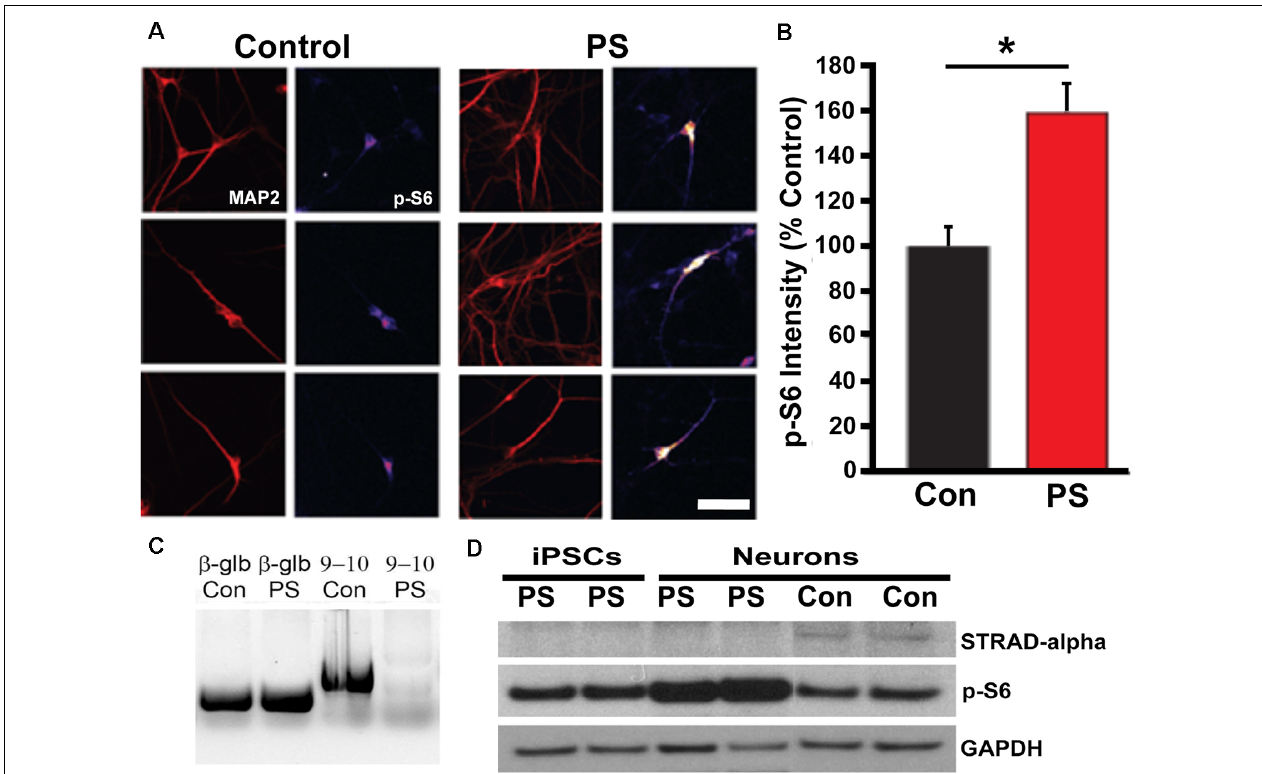
FIGURE 3 | STRADA and phosphorylated ribosomal-S6 (p-S6) expression in iPSC-derived control and PS neurons. (A) Immunocytochemistry for p-S6 of control vs. PS iPSC-derived neurons immunolabeled for p-S6 and MAP2abc. P-S6 signal is displayed as an intensity map (fire, NIH ImageJ), Scale bar = 40 um. (B) Mean p-S6 immunocytochemical signal intensity of control- vs. PS-derived MAP2+ neurons. The bar graph represents mean ± SD, with values normalized to the mean of the control samples. * p < 0.05 ( t -test). (C) Targeted PCR using primers spanning STRADA exons 9–10. Lane 1, beta-globin ( β -glb) detected in control (Con) individual fibroblast DNA (250 bp product); Lane 2, β -glb detected in PS fibroblast DNA; Lane 3, detection of STRADA exons 9–10 in control fibroblast genomic DNA (598 bp product); Lane 4, absence of STRADA exons 9–10 in PMSE fibroblast genomic DNA. (D) Western blot for: (1) STRADA protein (top row) showing absent expression in iPSCs and neurons derived from PS fibroblasts compared with control derived neurons (Con); (2) p-S6 protein (middle row) displaying increased p-S6 in PS neurons compared to PS iPSCs and control neurons; and (3) GAPDH loading control (bottom